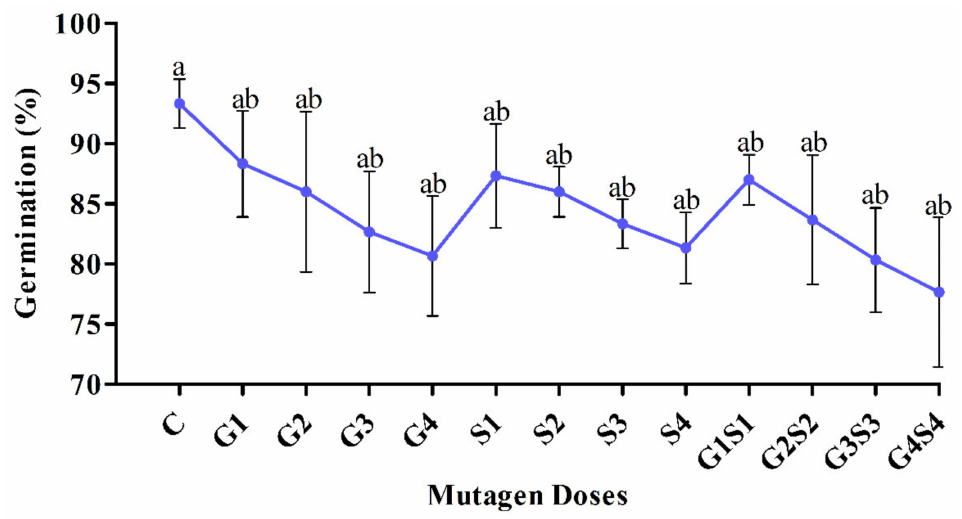
Figure 1. Effects of different doses of γ rays and SA on the seed germination in var. Gomati VU-89. The data is presented as percent (n = 300) and standard error. Line graphs with the same letters are not significant at a 5% level of significance, based on Duncan’s multiple range test (DMRT).